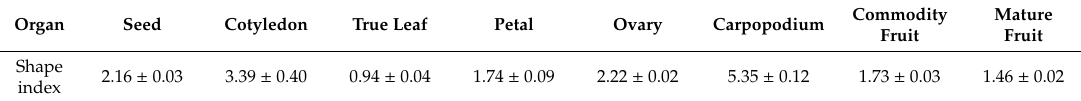
Table 7. Shape indexes of di ff erent organs in cucumber “16-1”.